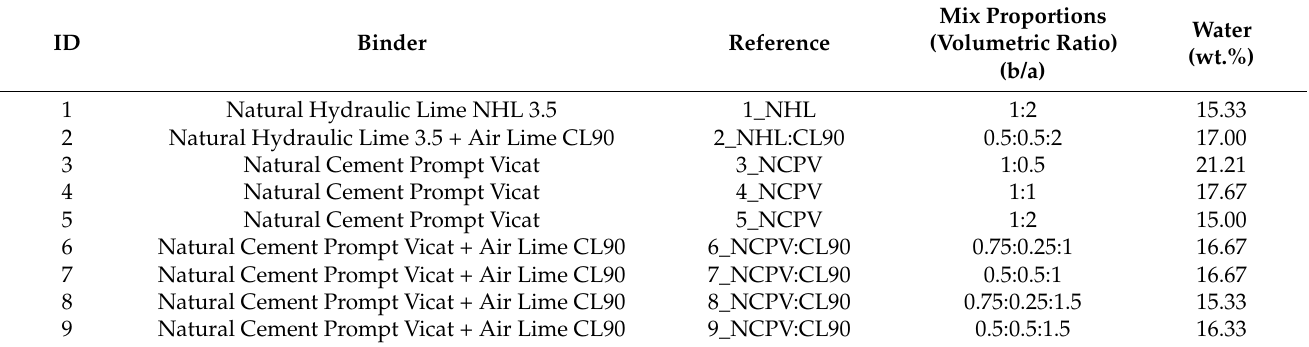
Table 1. Mix proportions and water